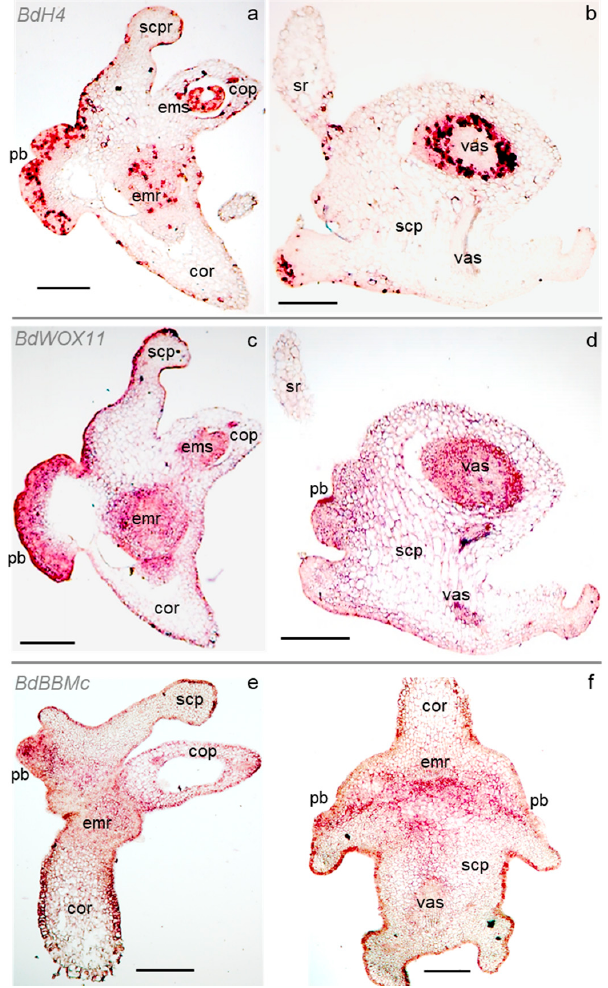
Figure 4. Expression of developmental genes in embryogenic tissues. Panels show RNA in situ hybridization of antisense RNA probes in cross-sections of d3 CIM izEmb explants, in the sagittal ( a , c , e ) or frontal ( b , d , f ) orientation. Detection of the transcript yields a ruby red signal, while some probes are associated with a brown background (compare with sense RNA probe controls in Supplementary Figure S1). cop—coleoptile; cor—coleorhiza; emr—embryonic root; ems—embryonic shoot;